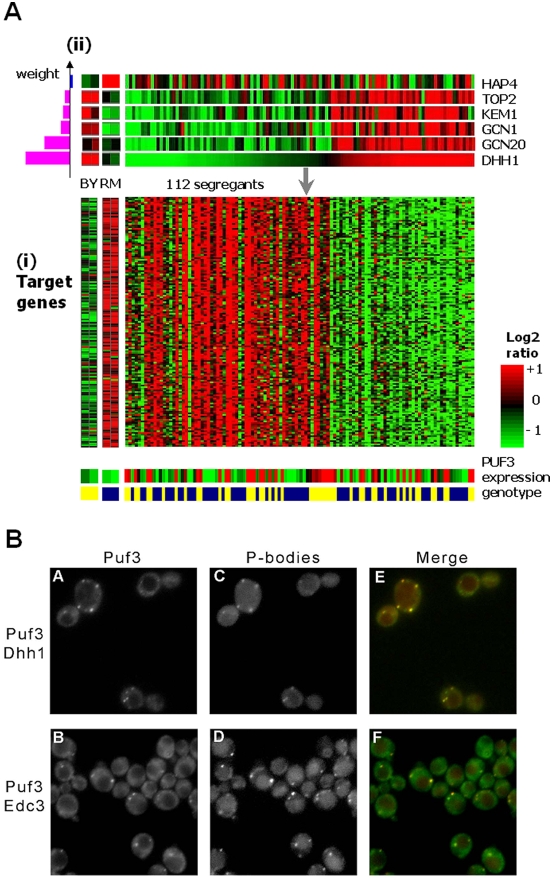
The Puf3 module.(A) A module of 153 target genes (i), which is strongly enriched for targets of the mRNA-binding protein Puf3 (shown on right, p<10−130; Figure S3), but neither the expression profile nor the genotype of Puf3 (shown on bottom: BY = blue, RM = yellow) are correlated with the module expression profile. (ii) The Lirnet regulatory program: the most significant predicted regulator is P-body component DHH1, but the regulatory program also contains P-body component Kem1, as well as translational regulators Gcn1/Gcn20. (B) Localization of Puf3 to P-bodies. Images of live cells containing a Puf3-GFP fusion and the P-body components Dhh1 or Edc3 fused to the red fluorescent protein tdimer2 (td2) (A) Puf3-GFP; (C) Dhh1-td2; (E) merged image; (B) Puf3-GFP; (D) Edc3-td2; (F) merged image. Strains containing only the Puf3-GFP fusion protein, i.e. no labeled P-body protein, formed similar fluorescent spots under the same environmental conditions (Figure S5). When present in the same cells, punctate spots of Puf3-GFP fluorescence significantly overlap with the punctate pattern formed by known P-body components (Table S10).